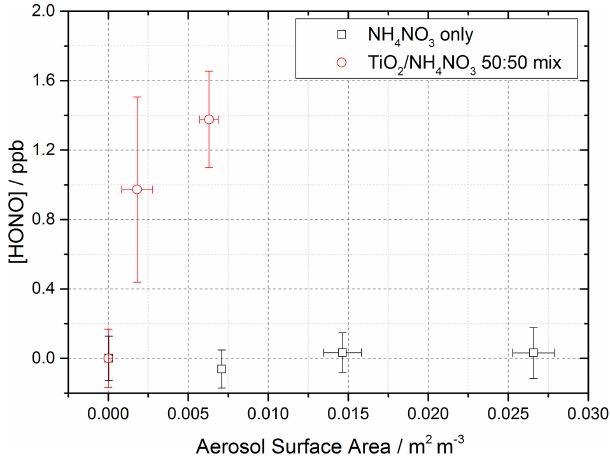
Figure 12. Dependence of [HONO] on the calculated nitrate con- centration in the aerosol (using the AIM model) for the mixed TiO 2 / ammonium nitrate aerosol experiment. Using Eq. (10) and for t = 30s, the gradient gives j ( p NO 3 ) = (3.29 ± 0.89) × 10 − 4 s − 1 . Experiment performed at 15 ± 1% RH, in N 2 at 295K with a lamp photon flux of (8.29 ± 2.39) × 10 16 photonscm − 2 s − 1 . For all points, the background HONO observed without illumination has been